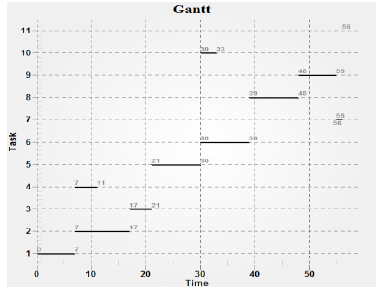
Fig.4. Schedule of Project 1(OS=0.3 RC=0.3)